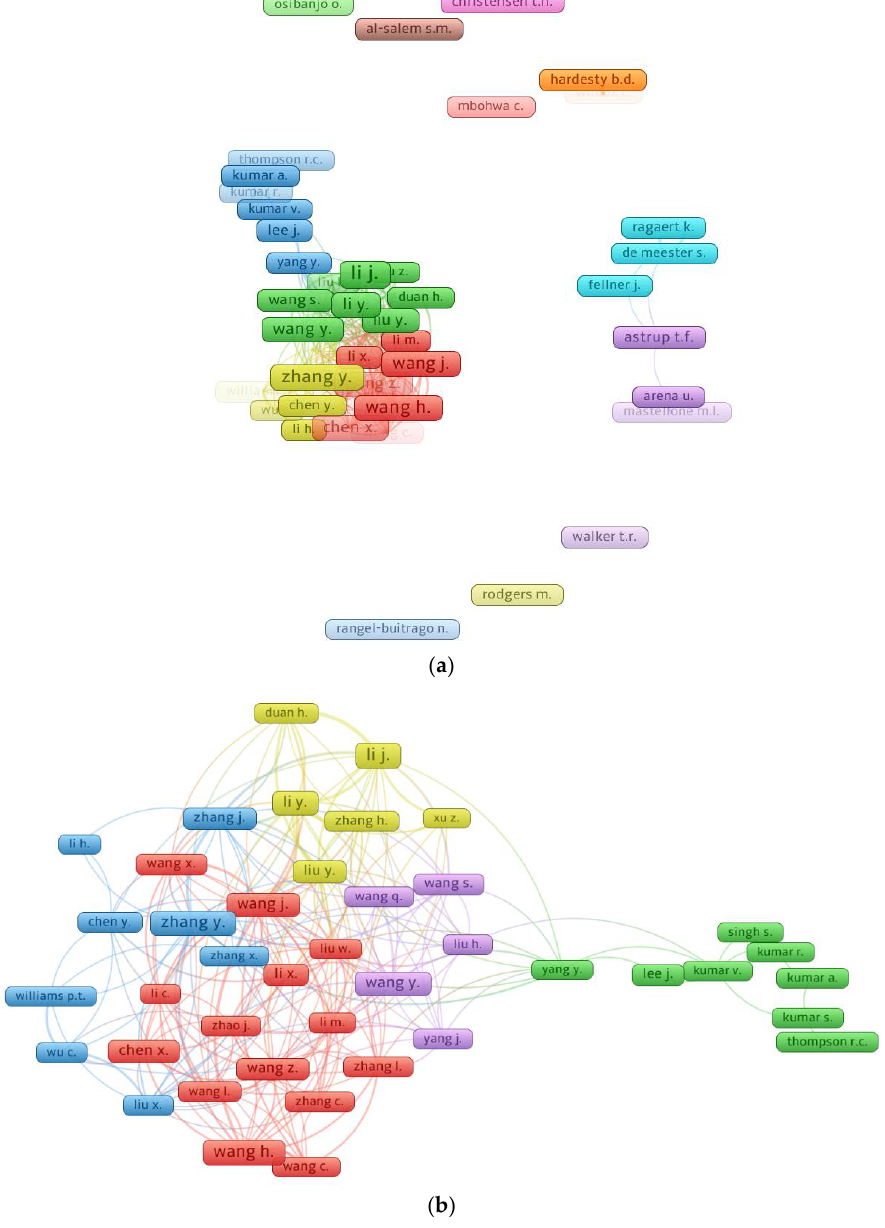
Figure 8. Science mapping of authors: ( a ) With a minimum of 10 publications; ( b ) Linked authors based on citations. Box size is proportional to the number of publications by a particular author, and color refers to the clustering of authors based on patterns of co-citation in the publications.